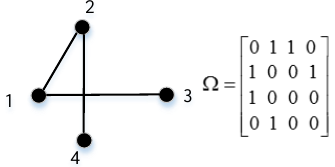
Figure 4. An example of the weighted adjacency matrix of a graph.